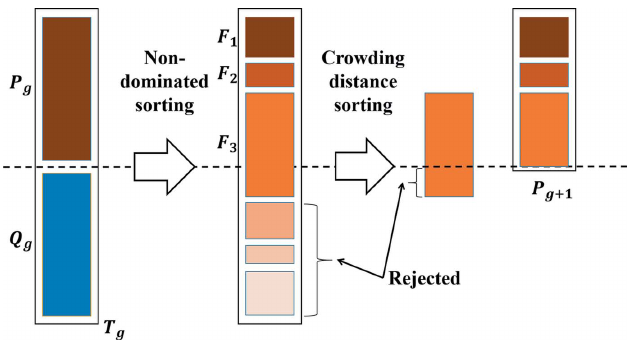
Figure 2 The non-dominated sorting genetic algorithm.